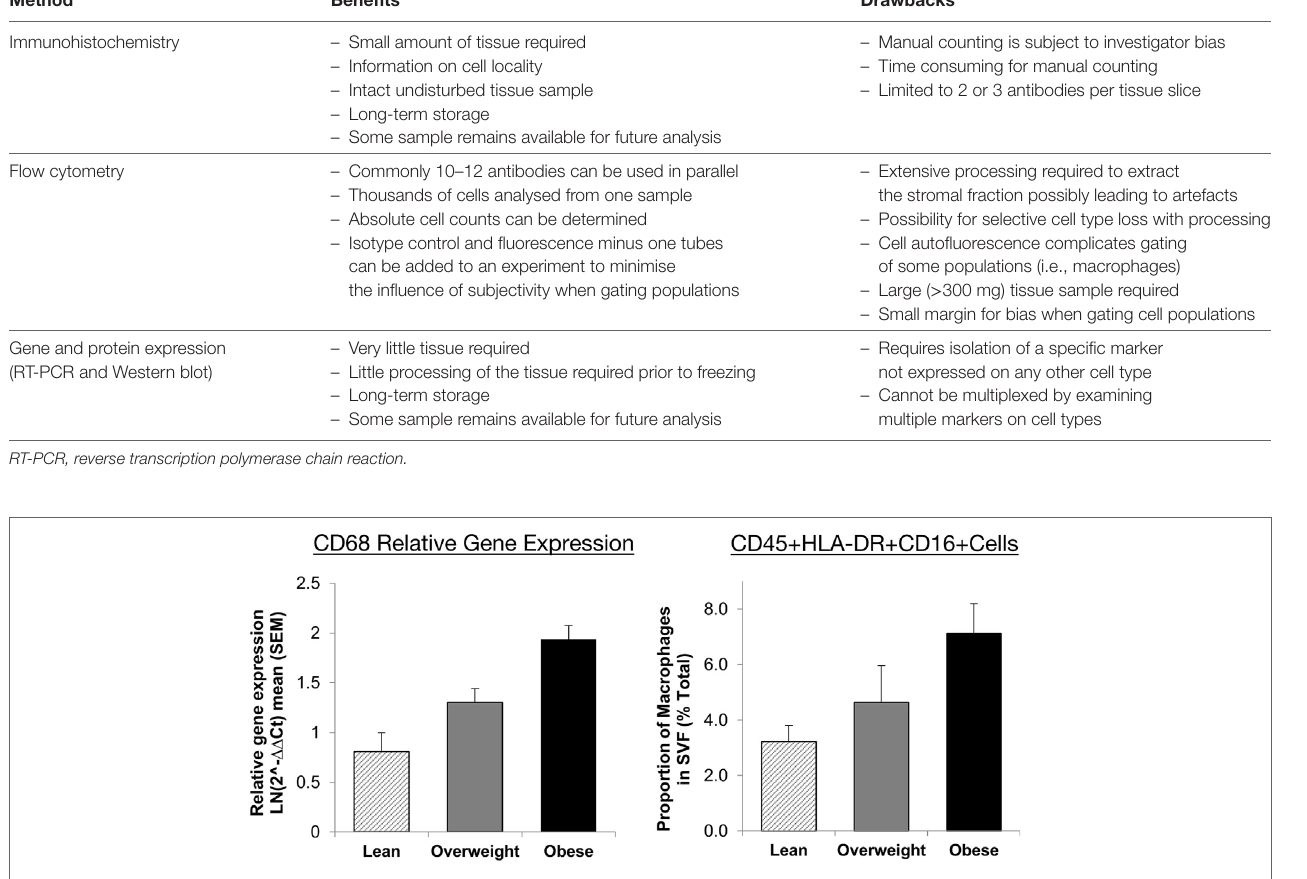
FiGURe 1 | Agreement between RT-PCR and flow cytometric assessment of macrophage abundance in lean, overweight, and obese individuals subcutaneous abdominal adipose tissue. Relative gene expression of CD68 was used to identify macrophages ( n = 30) and presented as mean 2 −ΔΔ Ct ± SEM. Proportions of macrophages in the adipose tissue SVF as a percentage of total cells ( n = 17). Macrophages were identified as CD45 + HLA-DR + CD16 + cells. Presented with permission from Travers et al. (35) . Abbreviations: CD, cluster of differentiation; HLA-DR, human leukocyte antigen-antigen D related; RT-PCR, reverse transcription polymerase chain reaction; SVF, stromal vascular fraction.